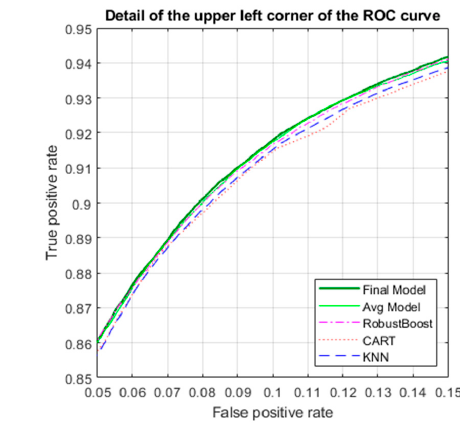
However, the detail of the upper left corner of the ROC curve identifies that the final